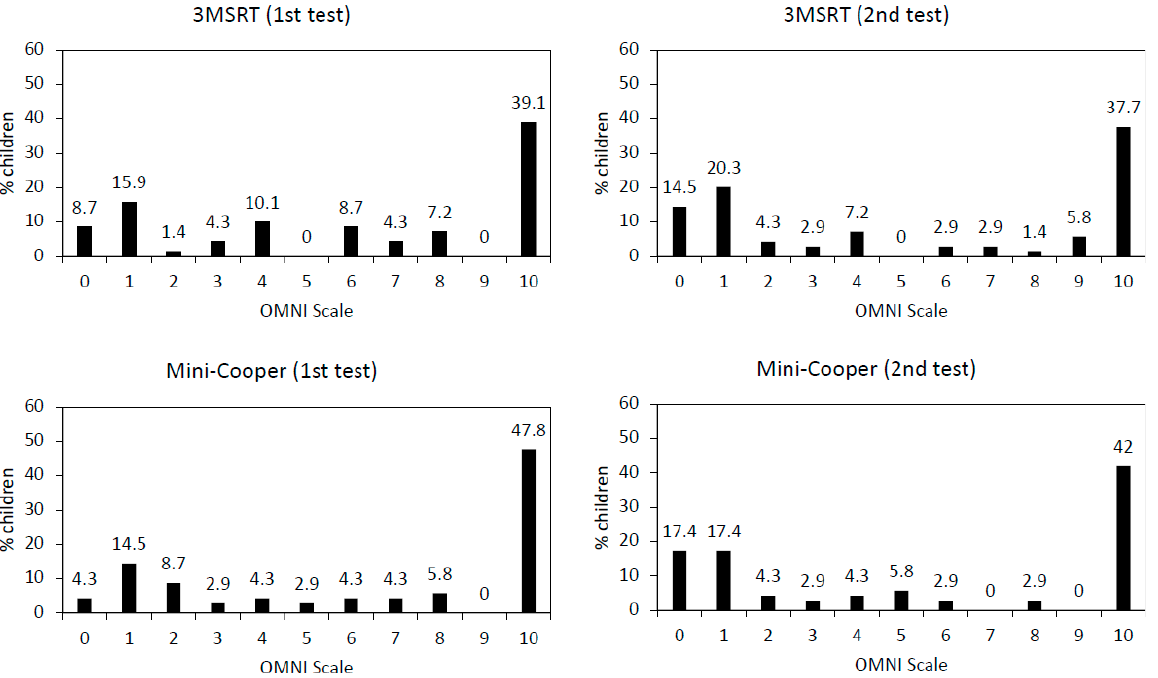
Figure 1. Results of the OMNI Scale administered in groups of five children, divided by group.